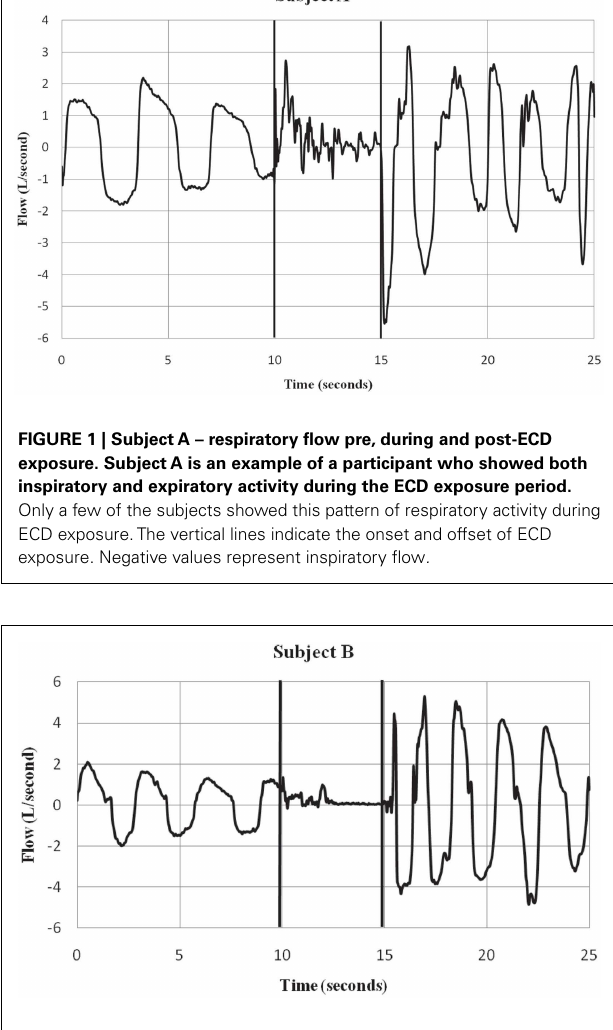
FIGURE 2 | Subject B – respiratory flow pre, during and post-ECD exposure. Subject B is an ex ample of a participant who showed a substantial inspiratory volume displacement from the pre-ECD to the exposure period. Most subjects showed this pattern of little or no inspiratory activity during the 5 -s exposure.The vertical lines indicate the onset and offset of EC D exposure. Negative values represent inspiratory